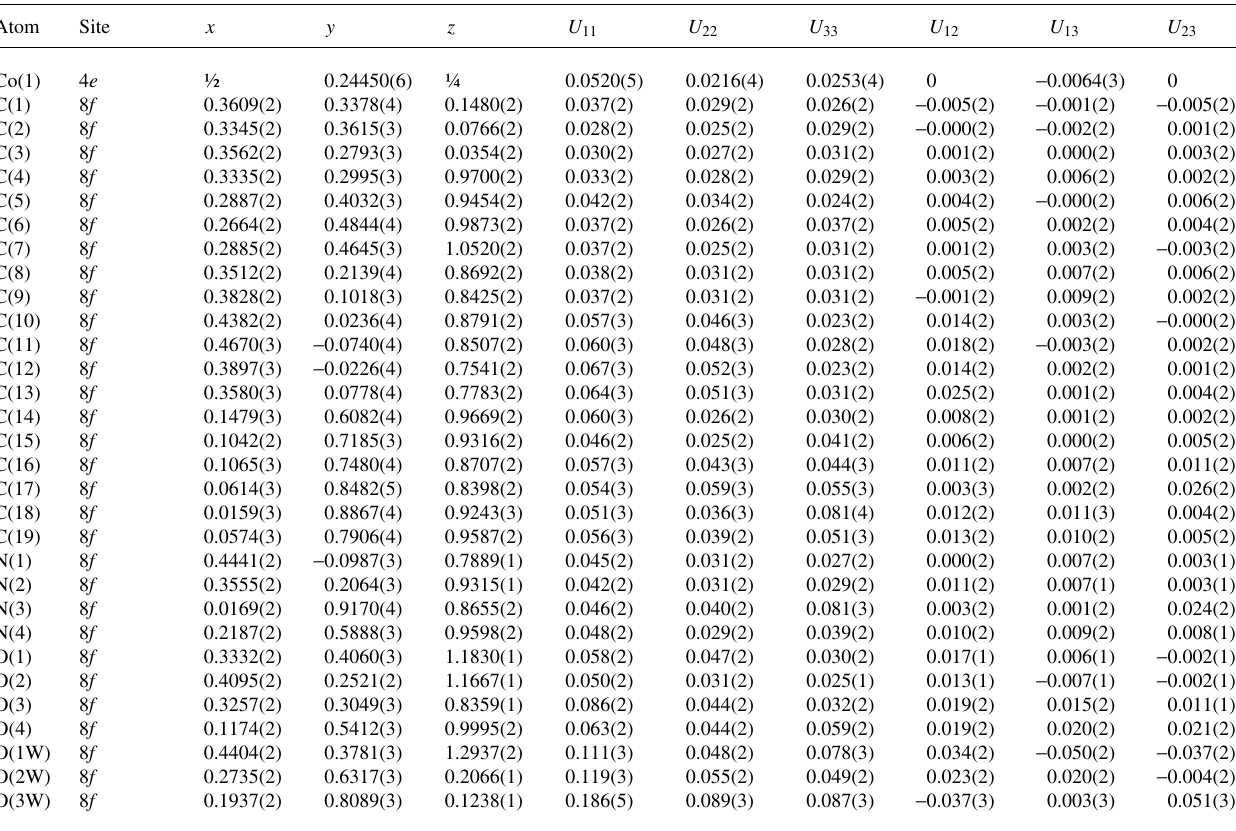
Table 3. Atomic coordinates and displacement parameters (in Å 2 )